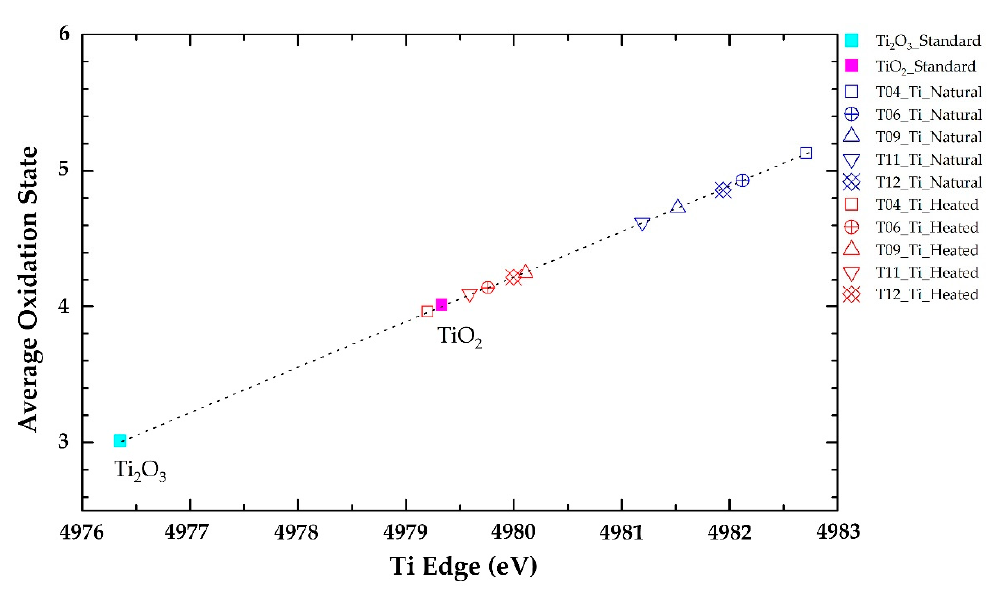
Figure 6. Plots of absorption edge energy (E0) of titanium in natural tanzanite samples and after heating experiment with a calibration curve (dotted line) fitted by standard Ti 2 O 3 and TiO 2 ; oxidation states of titanium tend to decrease after heating.